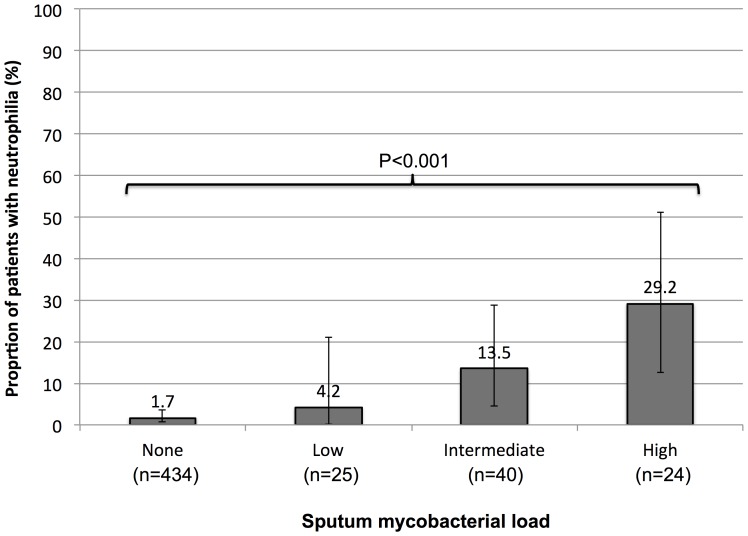
The proportion (with 95% confidence intervals) of patients with HIV-associated TB who have neutrophilia, stratified by increasing level of sputum mycobacterial load.